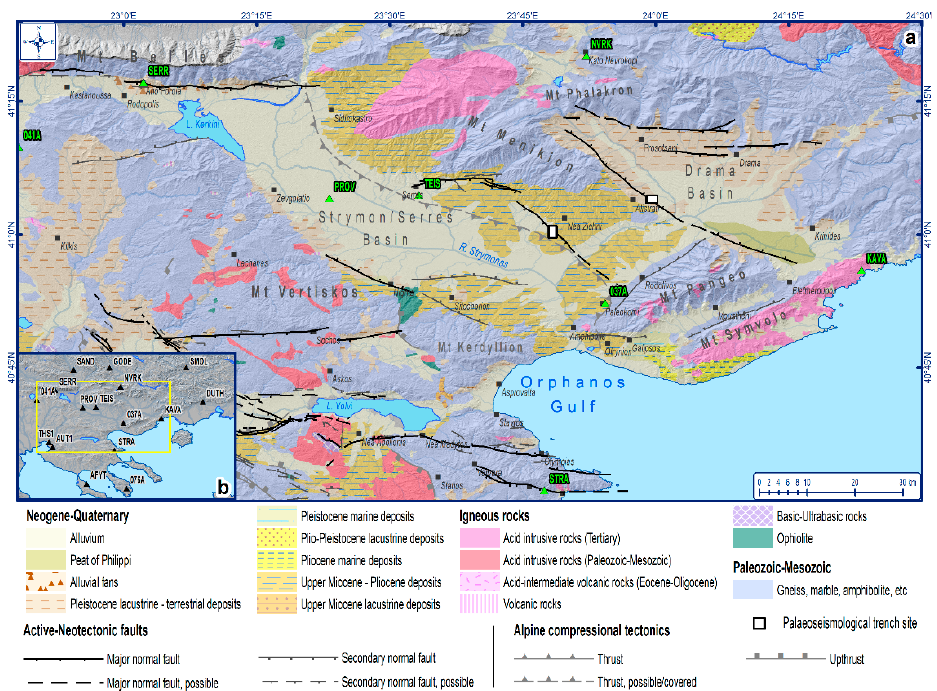
Figure 3. ( a ) Geological map of the broader Strymon region, showing the alpine and post-alpine formations and the alpine compressional tectonics [85], as well as the active-neotectonic faults as shown in Figure 1; ( b ) 16 permanent GNSS stations (black triangles), monitoring the broader Strymon region.